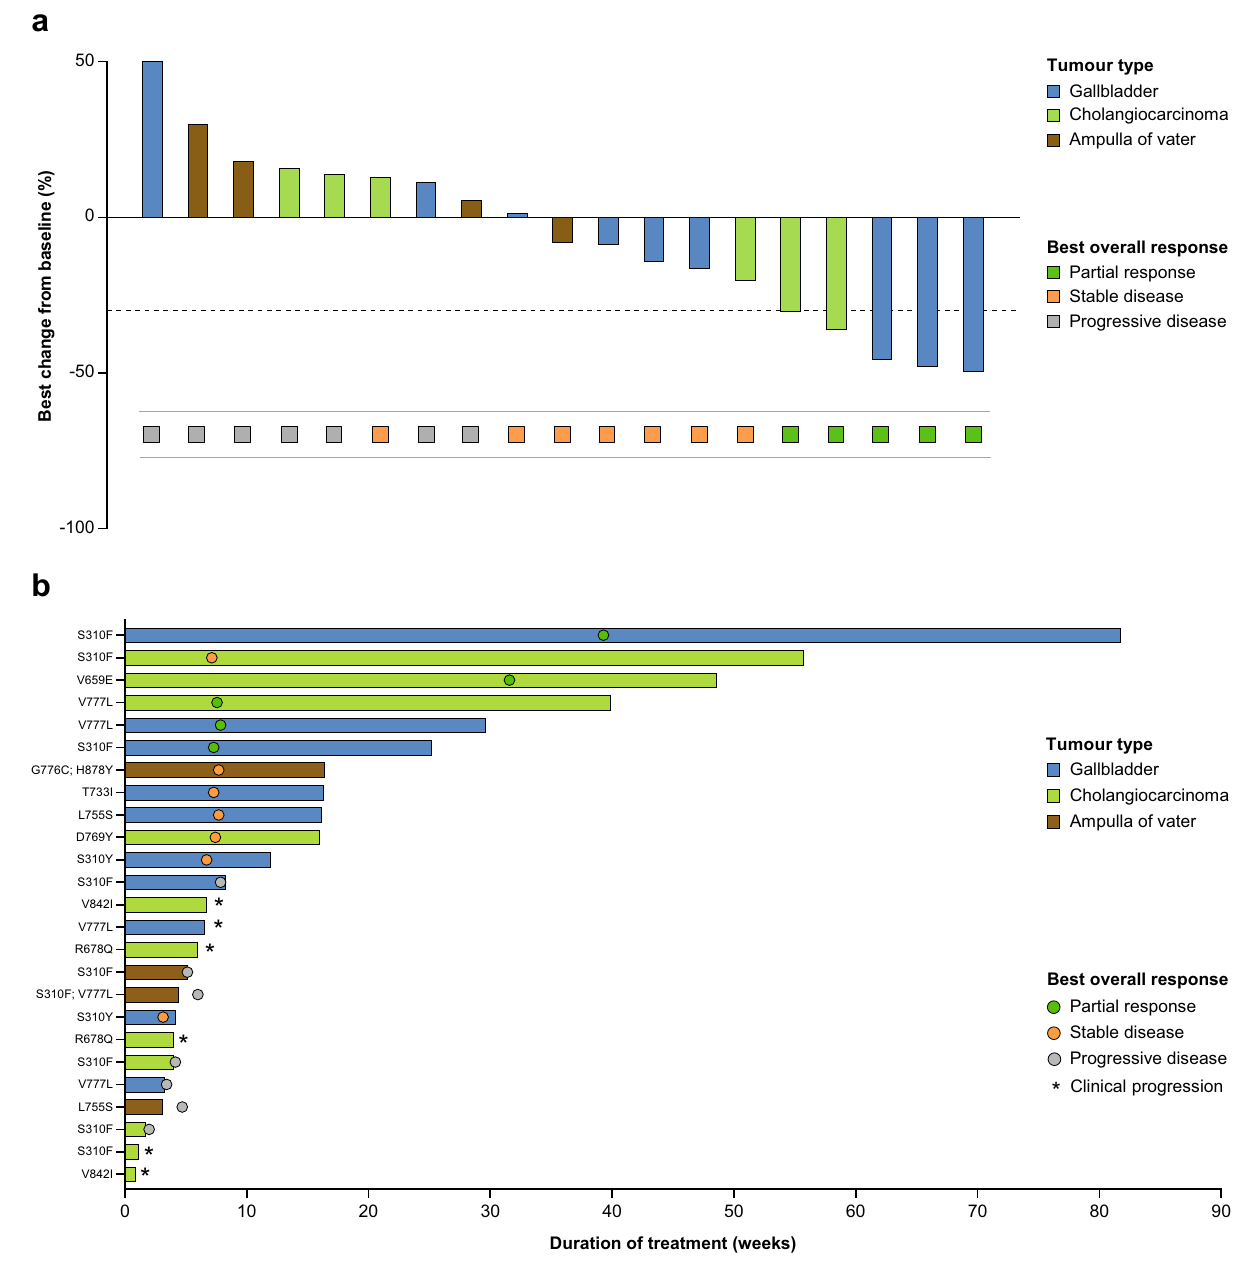
Fig. 2 | Activity of treatment ( n =25). a Waterfall plot for 19 patients with Response Evaluation Criteria in Solid Tumours (version 1.1)-evaluable disease; six patients who were not evaluable are not depicted. Dotted line indicates − 30%